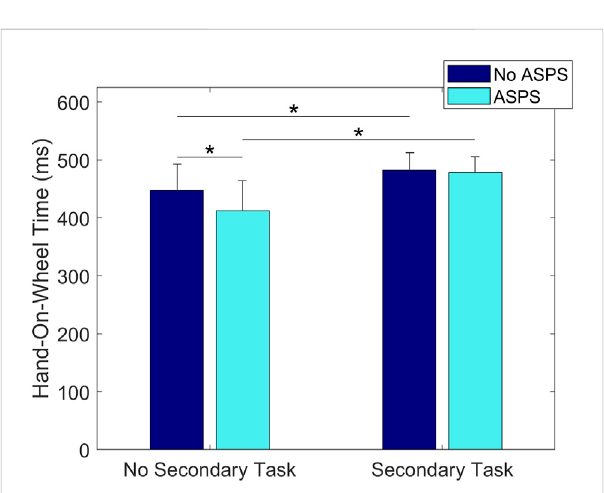
FIGURE 7 Group means ± SD for Hand-On-Wheel Time with and without the ASPS in conditions without and with the Secondary